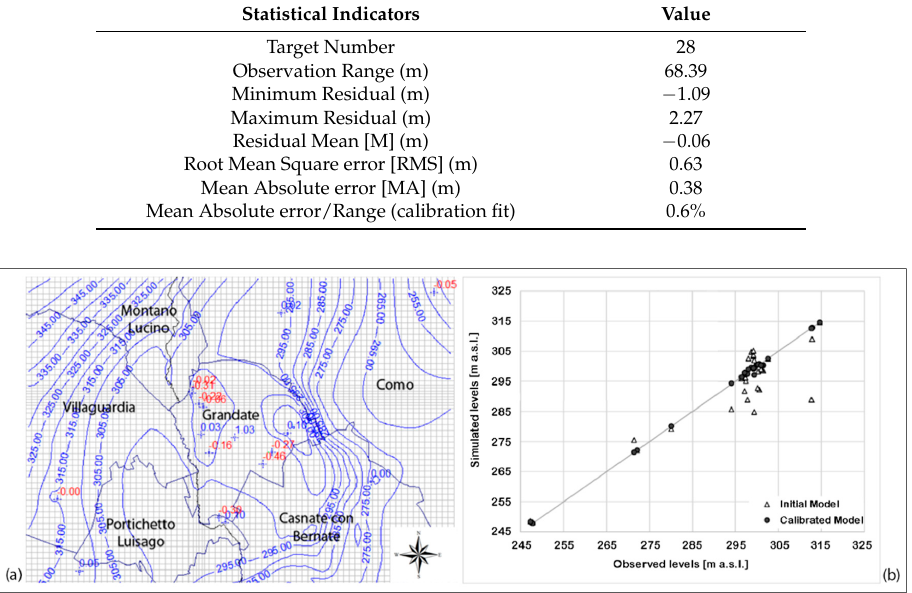
Figure 11. ( a ) Model simulation result and observed-simulated values—zoom on Grandate, ( b ) observed/simulated scatterplot before and after the calibration procedure.